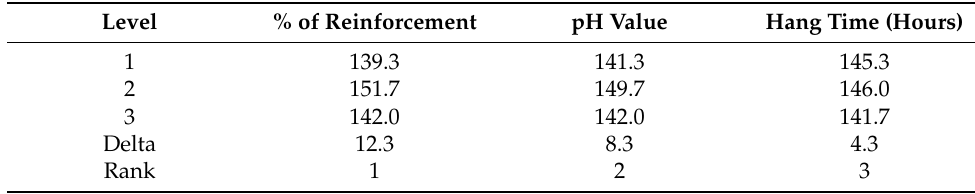
Table 19. Response table for means (microhardness test).